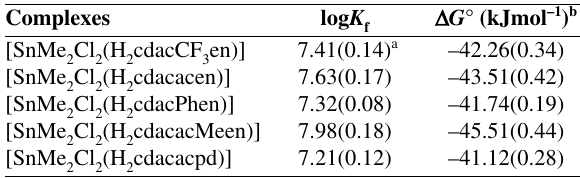
Table 5. The formation constants, log K ( Δ G °) of tin (IV) complexes at 25 °C in DMF